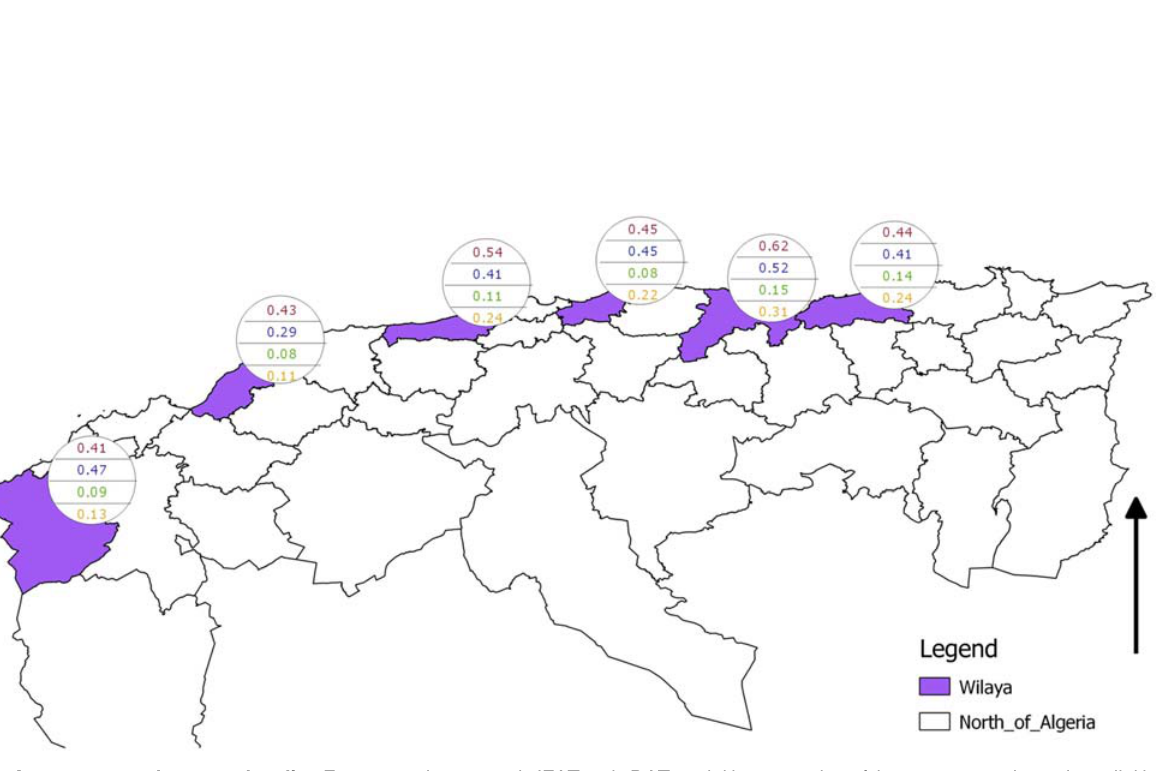
PLOS ONE | DOI:10.1371/journal.pone.0117313 March 20,